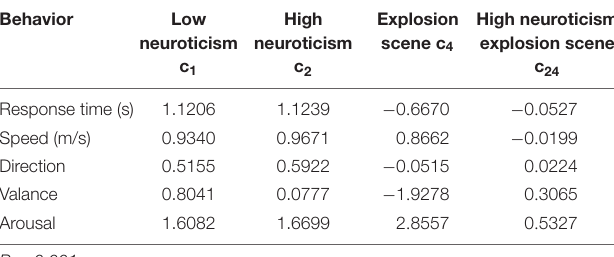
TABLE 8 | Interaction of neuroticism and experimental scene on individual emotional impact and escape behavior.